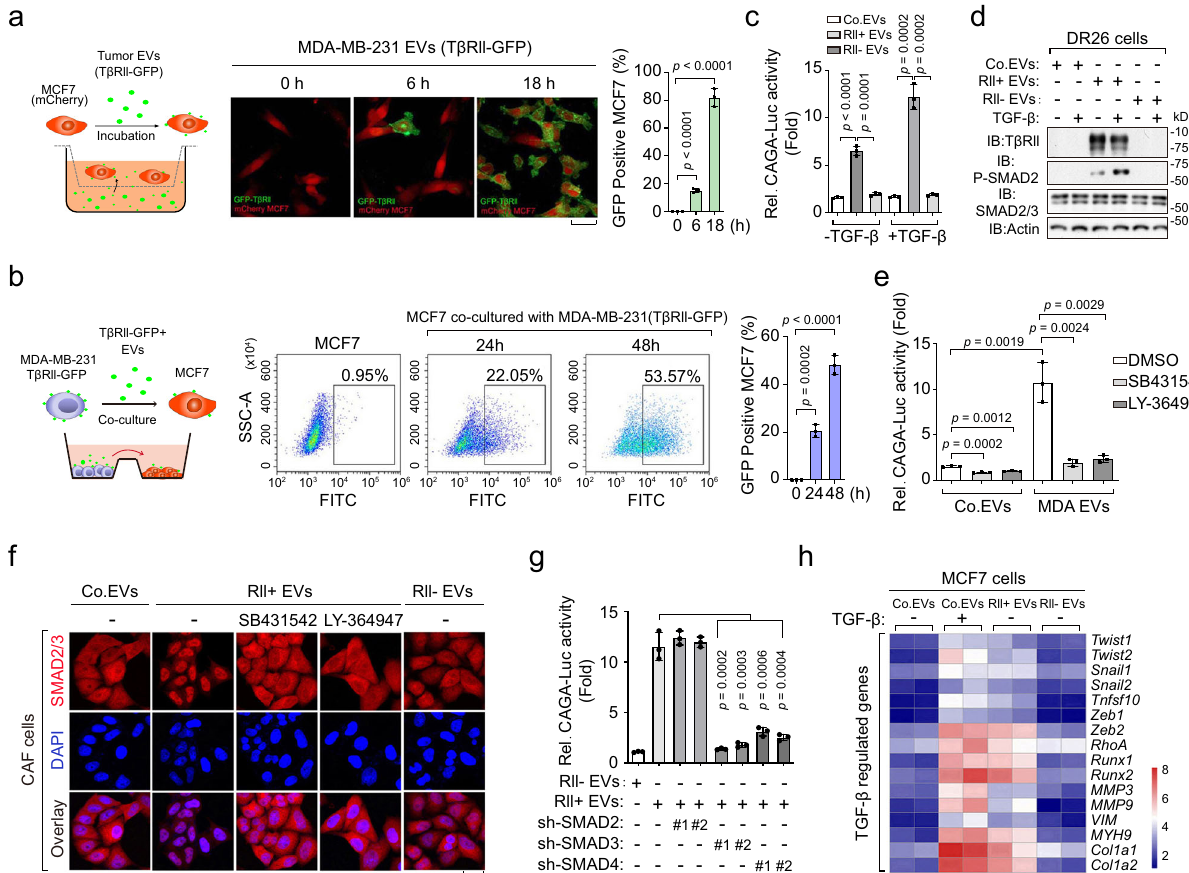
Fig. 4 EV-T β RII mediates the TEVs-induced SMAD activation in recipient cells. a Schematic diagram (left panel), confocal microscopy (middle panel) and quanti fi cation (right panel) of MCF7 cells incubated with EVs derived from MDA-MB-231 cells stably expressing T β RII-GFP for indicated times. Scale bar, 20 μ m. b Schematic diagram (left panel), FACS analysis (middle panel) and quanti fi cation (right panel) of MCF7 cells incubated with MDA-MB-231 cells stably expressing T β RII-GFP for indicated times. c Transcriptional analysis of TGF- β -induced (2.5 ng/ml for 16 hrs) CAGA 12 -Luc response in T β RII- de fi cient mink lung epithelial DR26 cells pre-treated for 24 h with empty liposome (as a control; Co.EVs), T β RII + (RII + ) EVs (40 μ g) derived from untransfected MDA-MB-231 cells or T β RII − (RII − ) EVs (40 μ g) derived from T β RII knockout MDA-MB-231 cells. d Immunoblot analysis of total lysates of DR26 cells pre-incubated with empty liposome (as a control; Co.EVs) or EVs (40 μ g) derived from T β RII + (RII + ) or T β RII − (RII − ) MDA-MB-231 cells, and stimulated with TGF- β (2.5 ng/ml) for 1 h as indicated. e Transcriptional analysis of CAGA 12 -Luc response in T β RII-de fi cient DR26 cells incubated with empty liposome (as a control; Co.EVs) or EVs (40 μ g) derived from T β RII + (RII + ) MDA-MB-231 cells (MDA EVs) and treated with control DMSO, SB431542 (10 μ M) or LY-364947 (10 μ M) as indicated. f Immuno fl uorescence and DAPI staining of CAF cells pre-incubated with Co.EVs, T β RII + or T β RII − EVs (40 μ g) and treated with control DMSO, SB431542 (10 μ M) or LY-364947 (10 μ M) as indicated. Scale bar, 20 μ m. g Transcriptional analysis of CAGA 12 -Luc response in HEK293T cells as indicated pre-treated for 24 h with EVs (40 μ g) derived from T β RII + (RII + ) or T β RII − (RII − ) MDA-MB-231 cells. h qPCR analysis in MCF7 cells pre-incubated for 48 h with Co.EVs, T β RII + or T β RII − EVs (40 μ g), followed by no stimulation ( − ) or stimulation ( + ) for 16 h with TGF- β (2.5 ng/ml). Relative mRNA levels are shown as a heatmap. * p < 0.05 (two-tailed Student ’ s t test ( a , b , c , e , g )). Data are analyzed of three independent experiments and shown as mean + SD ( a , b , c , e , g ). Source data are provided as a Source Data fi